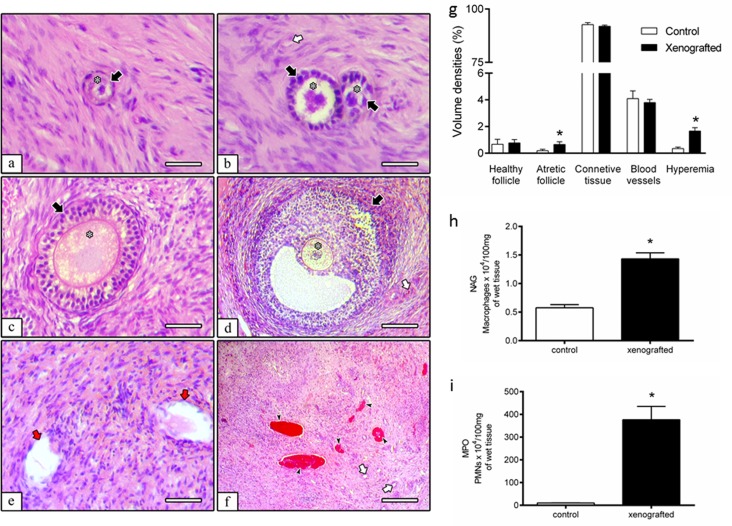
Progression of folliculogenesis, morphometry and inflammatory cell numbers in xenografted and in control ovarian fragments.(a) Primordial, (b) primary, (c) secondary, (d) antral and (e) atretic follicles were noted 10 days after xenotransplantation. (g) Volumetric density (%) of ovarian pieces before and after xenotransplantation showing a higher incidence of follicular atresia and hyperemia (f; P<0.01) after this procedure. (h, i) As demonstrated using (h) NAG and (i) MPO assays in xenografted ovarian wet tissue, higher concentration of host-derived macrophages and neutrophils were observed (P<0.01). Black arrows = healthy follicles; red arrows = atretic follicles; white arrows = blood vessels; black arrowhead = hyperemia; asterisks = oocytes. Bars in a, b, c and e = 80 μm and d and f = 150 μm.